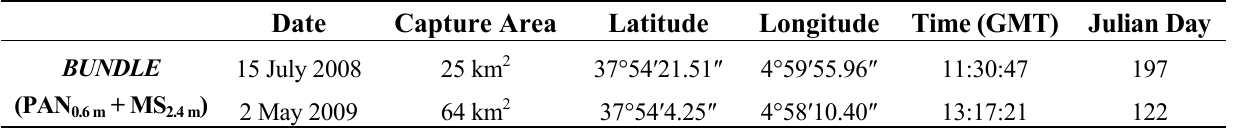
Table 1. QuickBird Imagery